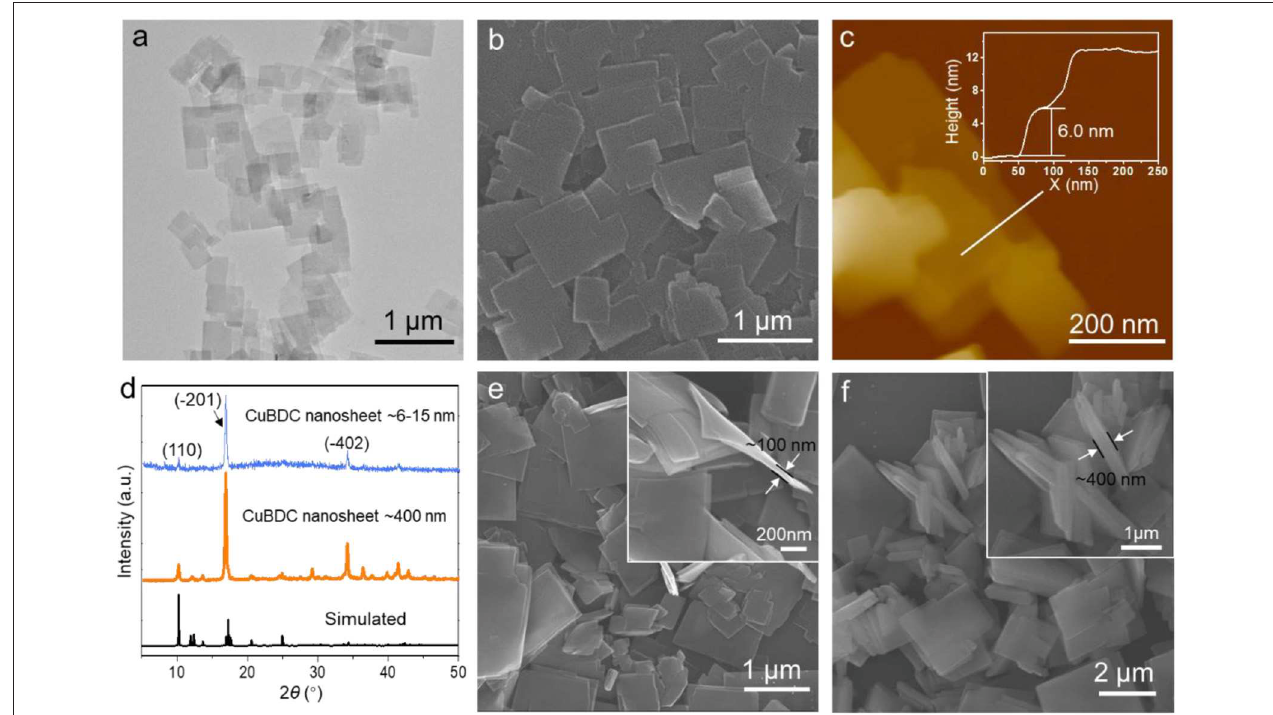
FIGURE 2 | (a–d) TEM (a) , SEM (b) , AFM (c) images, and XRD pattern (d) of CuBDC nanosheets. (e,f) SEM images of CuBDC nanosheets with different thickness synthesized at DMF:H 2 O = 3:1 (e) and 2:2 (f) , respectively (the insets of the high magnification SEM images show the thickness of the